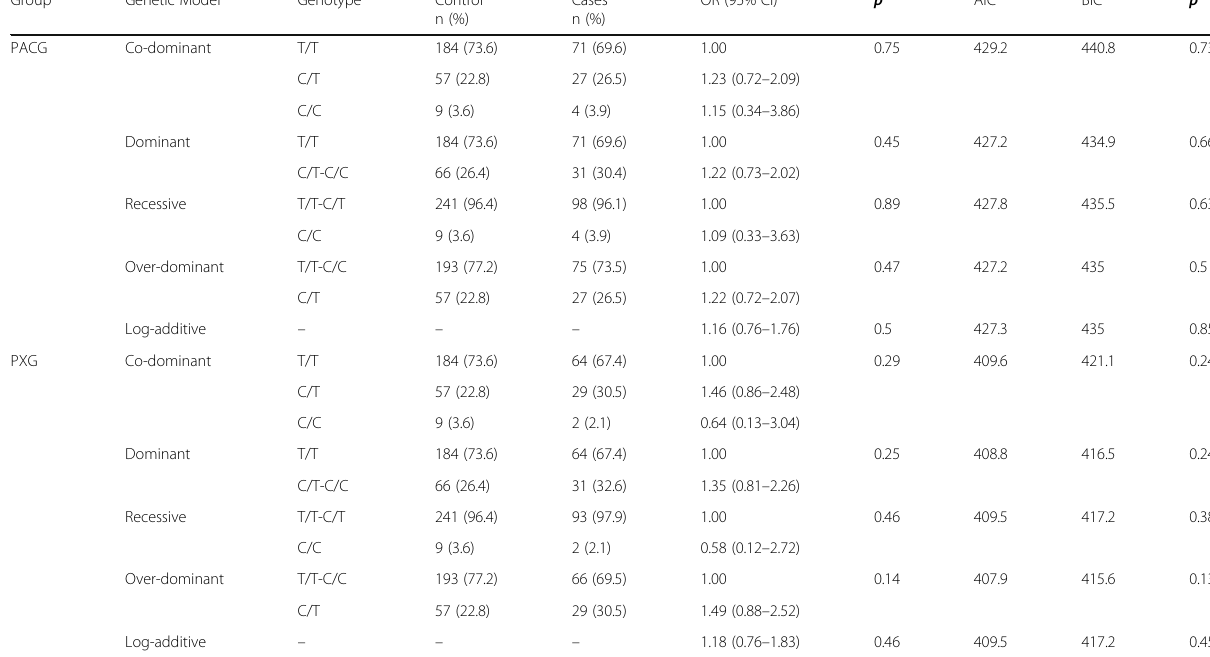
Table 5 Association analysis of rs1043784 variant in BMP6 in cases and controls according to glaucoma types Group